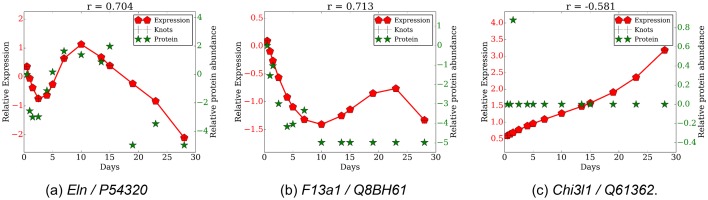
Comparison of gene expression and protein abundance for selected gene protein pairs.(a) Eln/P54320, (b) F13a1/Q8BH61, (c) Chil1/Q61362.